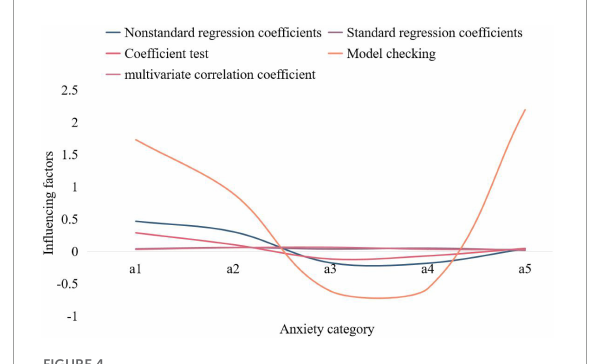
FIGURE4 Influencing factors of anxiety of poor university